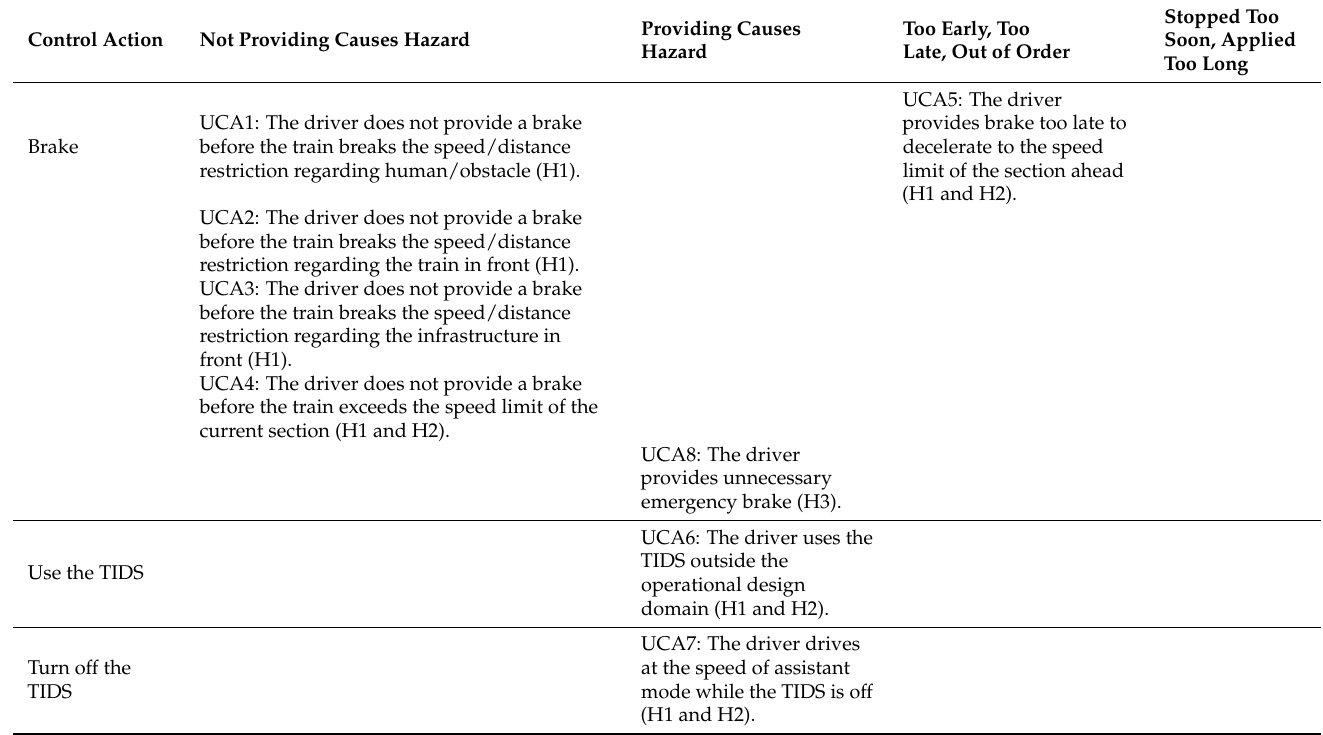
Table 2. The identified unsafe control actions